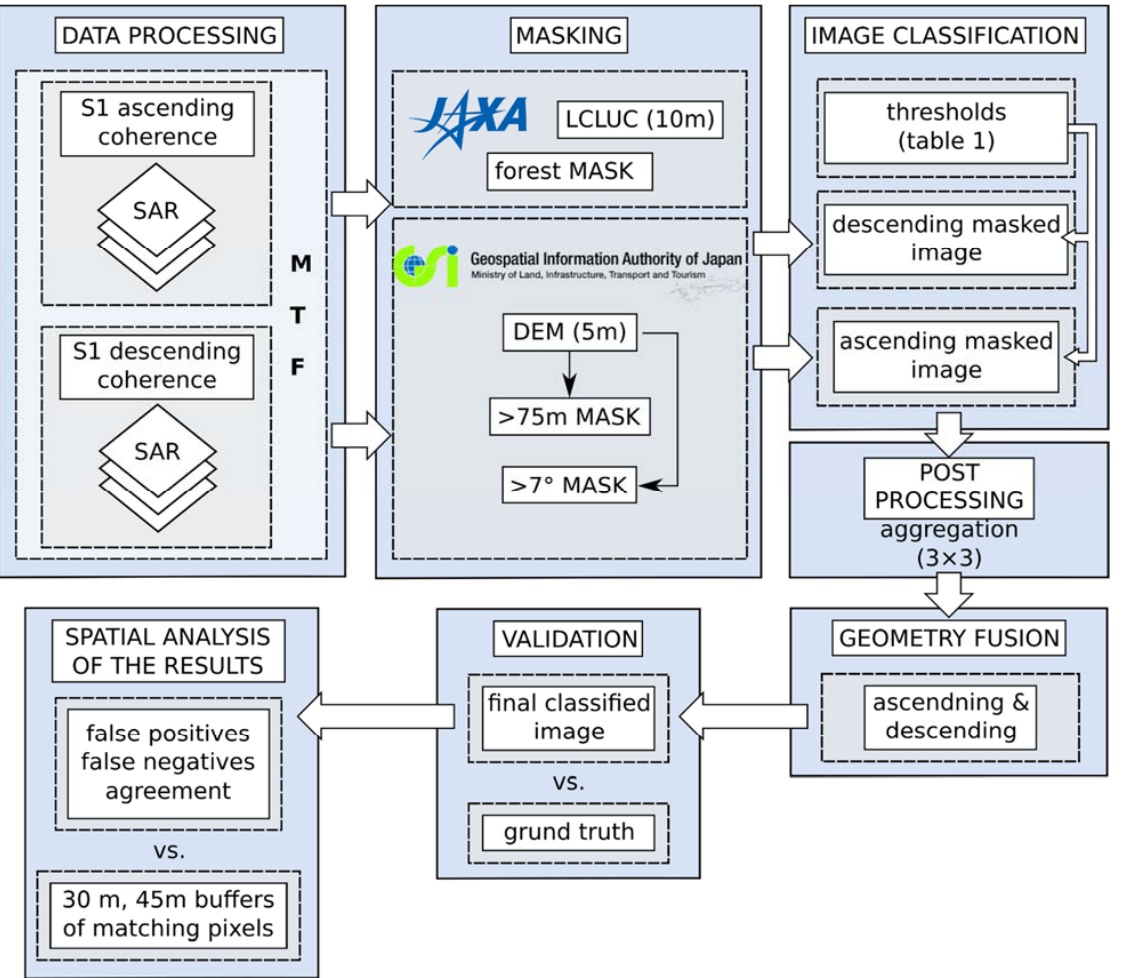
Figure 7. Scheme of image classification and following processing